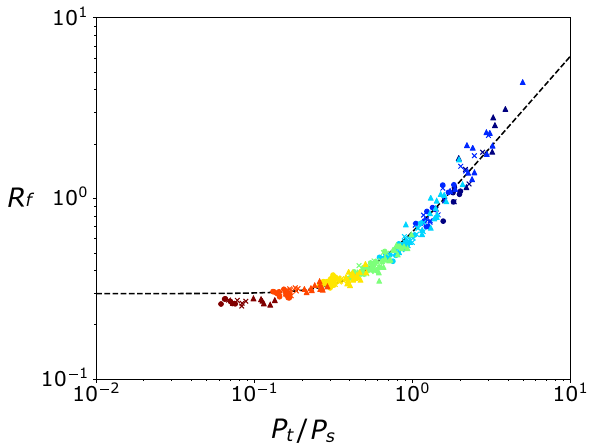
P b / P s ) in the pure ST simulations ≡ − 3.5 and 4.0 < t / T 5.0 . Symbols and colors are the same as in Fig. 2. f < f <